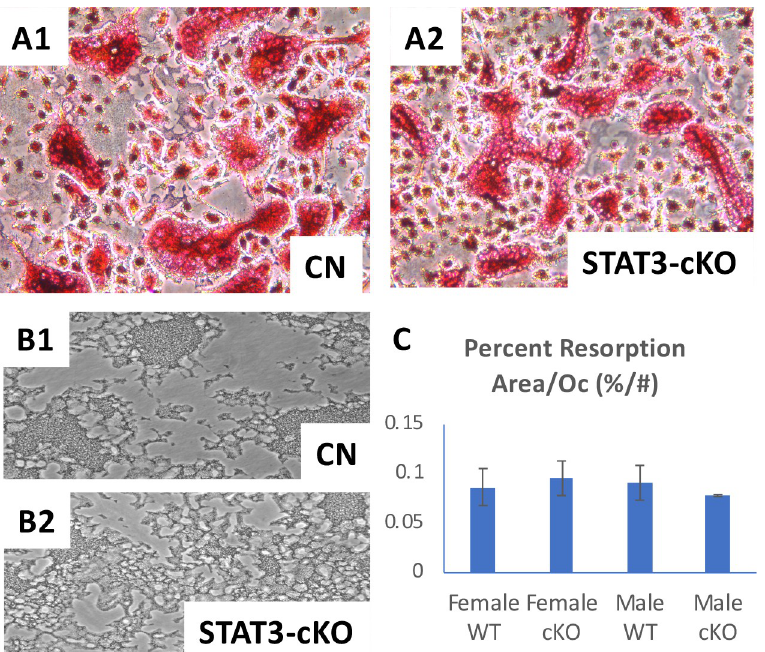
Fig 5. Primary osteoclast-like cells were generated from murine bone marrow monocytes (BMMs) of 6 week old STAT3-cKO and the littermate control (CN) mice and cultured with the addition of M-CSF and RANKL. TRAP stained osteoclasts from CN mice (A1) and STAT3-cKO (A2) (n = 2/group). Resorption assay showed that the resorbed surface appears darker than unresorbed surface of the culture plates using CN (B1) and STAT3-cKO (B2) osteoclasts. C: Quantitation of the percentage resorption area normalized by osteoclast number showed no significant difference between female and male CN and STAT3-cKO osteoclasts.